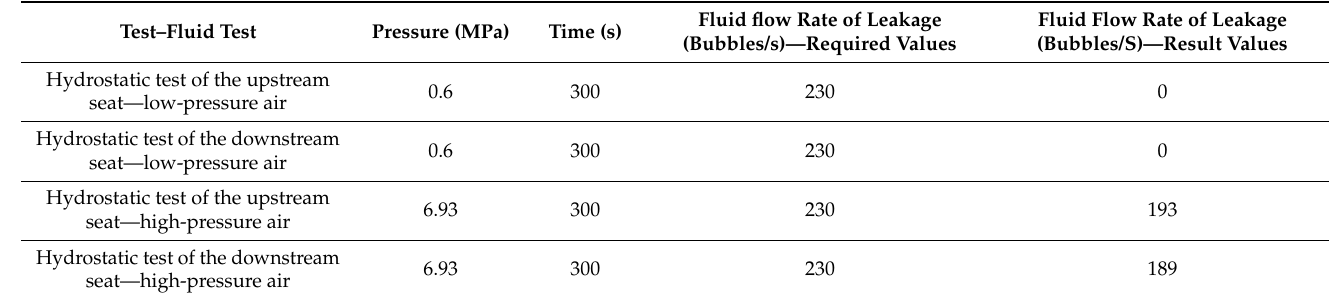
Table 3. Results of hydrostatic tests with air as the working